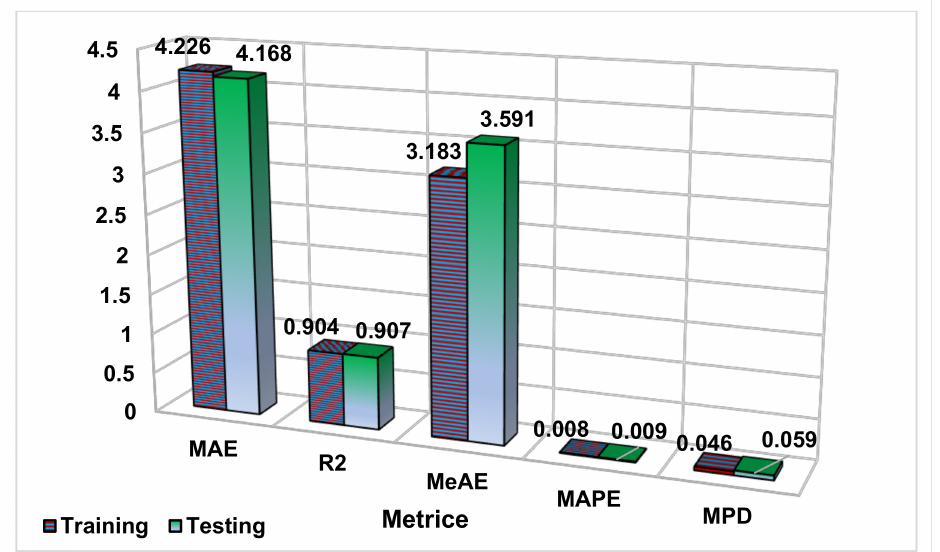
Figure 11. The different forms of errors were analyzed in the Linear regressor obtained from the training and testing points (R 2 is shown as R2 in the horizontal